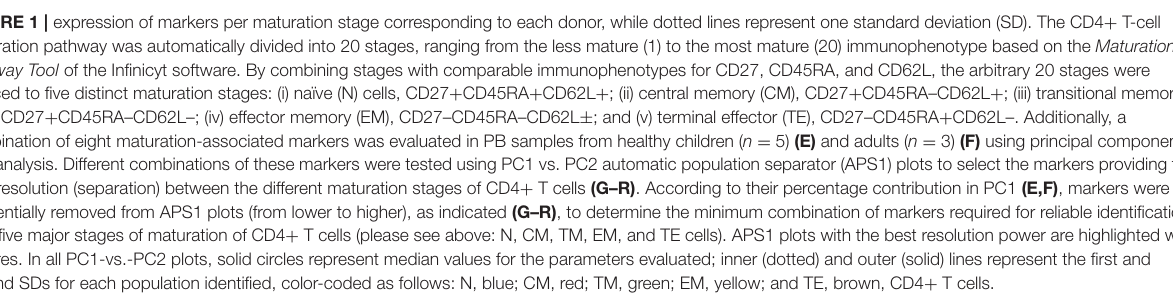
FIGURE 1 | expression of markers per maturation stage corresponding to each donor, while dotted lines represent one standard deviation (SD). The CD4 + T-cell maturation pathway was automatically divided into 20 stages, ranging from the less mature (1) to the most mature (20) immunophenotype based on the Maturational Pathway Tool of the Infinicyt software. By combining stages with comparable immunophenotypes for CD27, CD45RA, and CD62L, the arbitrary 20 stages were reduced to five distinct maturation stages: (i) naïve (N) cells, CD27 + CD45RA + CD62L + ; (ii) central memory (CM), CD27 + CD45RA–CD62L + ; (iii) transitional memory (TM), CD27 + CD45RA–CD62L–; (iv) effector memory (EM), CD27–CD45RA–CD62L ± ; and (v) terminal effector (TE), CD27–CD45RA + CD62L–. Additionally, a combination of eight maturation-associated markers was evaluated in PB samples from healthy children ( n = 5) (E) and adults ( n = 3) (F) using principal component (PC) analysis. Different combinations of these markers were tested using PC1 vs. PC2 automatic population separator (APS1) plots to select the markers providing the best resolution (separation) between the different maturation stages of CD4 + T cells (G–R) . According to their percentage contribution in PC1 (E,F) , markers were sequentially removed from APS1 plots (from lower to higher), as indicated (G–R) , to determine the minimum combination of markers required for reliable identification of all five major stages of maturation of CD4 + T cells (please see above: N, CM, TM, EM, and TE cells). APS1 plots with the best resolution power are highlighted with squares. In all PC1-vs.-PC2 plots, solid circles represent median values for the parameters evaluated; inner (dotted) and outer (solid) lines represent the first and second SDs for each population identified, color-coded as follows: N, blue; CM, red; TM, green; EM, yellow; and TE, brown, CD4 + T